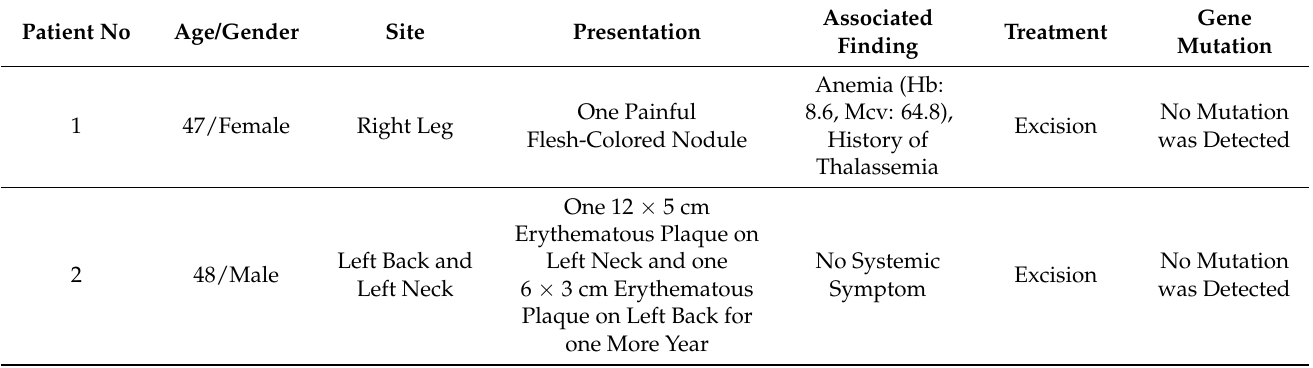
Table 1. Summary of patients’ clinical characteristics and molecular data.